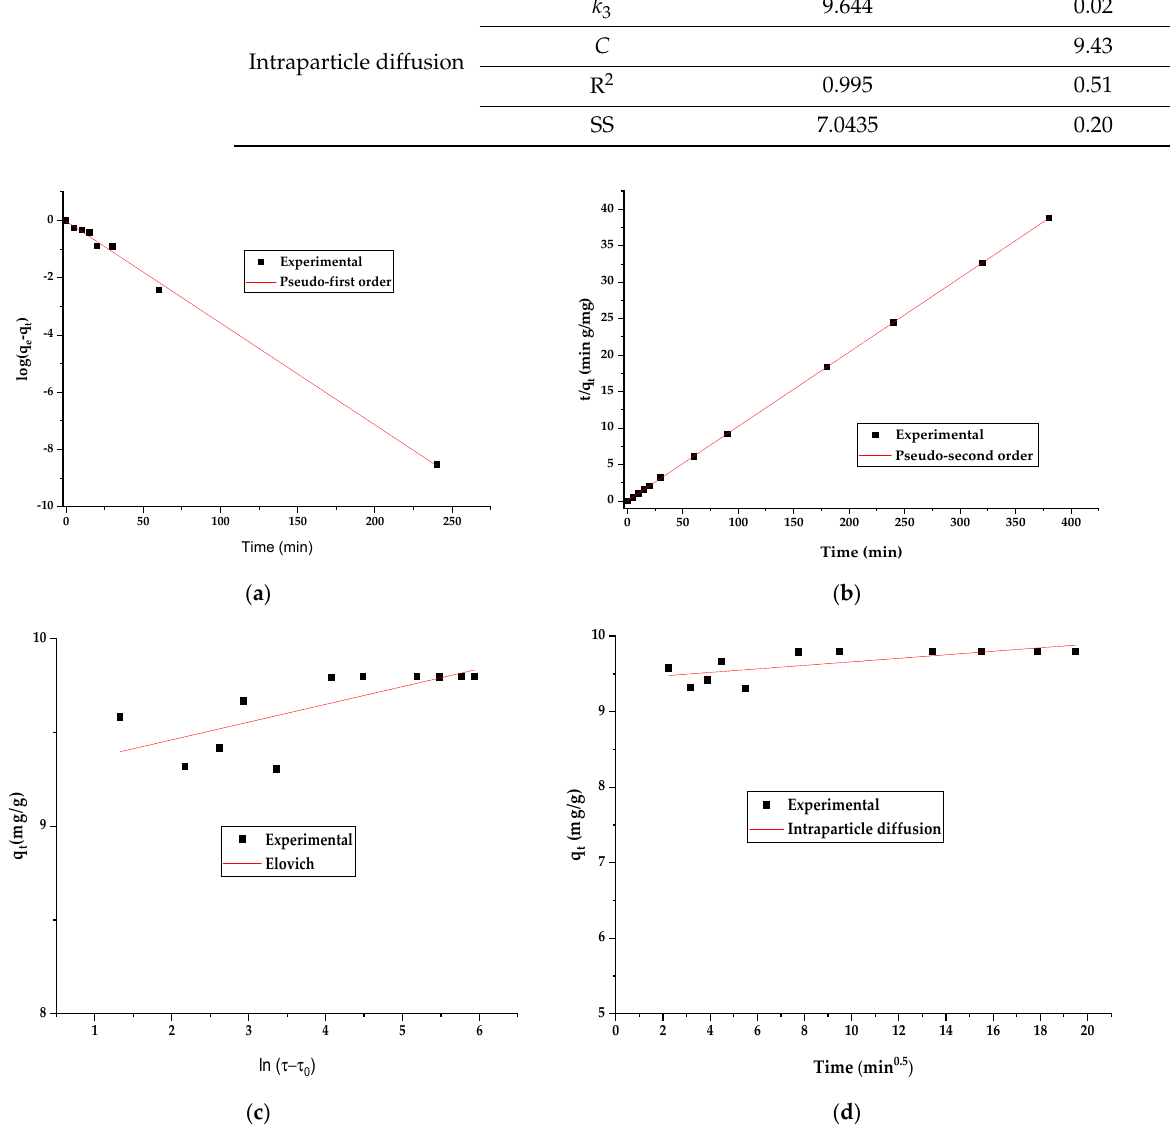
Figure 8. Kinetic linear adjustment of the adsorption kinetics of Cr (VI) to ( a ) pseudo-first order model, ( b ) pseudo-second order mode, ( c ) Elovich and ( d ) intraparticle diffusion; at pH 2, 55 °C, 200 mg L − 1 and 0.14 g of adsorbent.